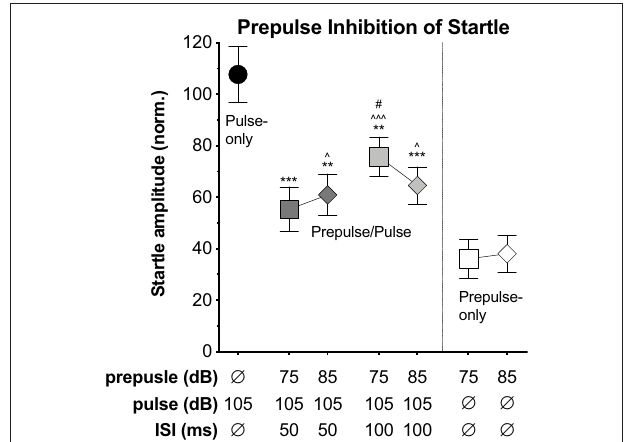
FIGURE 4 | Prepulse inhibition (PPI). Average normalized startle amplitude elicited by the pulse alone, the pulse when preceded by a prepulse, or the prepulse alone. The pulses were 200ms, 105 dB white noise bursts with a 0ms rise time. The prepulses were 4ms, 75 or 85 dB white noise bursts with a 0ms rise time. The inter-stimulus intervals (ISI) between the prepulse and pulse on prepulse/pulse trials were either 50 or 100ms. Normalized startle amplitude was significantly lower at all prepulse/pulse conditions relative to the pulse-only condition. Within the two 75 dB prepulse/pulse conditions, normalized startle amplitude was significantly higher at the 100ms ISI relative to the 50ms ISI. Normalized startle amplitude was significantly higher at the 75 dB, 100ms ISI prepulse/pulse condition relative to the 75 dB prepulse-only condition and at both 85 dB prepulse/pulse conditions relative to the 85 dB prepulse-only condition. Starred data points identify significant comparisons against the pulse-only condition (** P < 0.01, *** P < 0.001), the prepulse/pulse